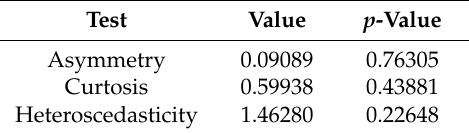
Table 4. Validation test of the method.